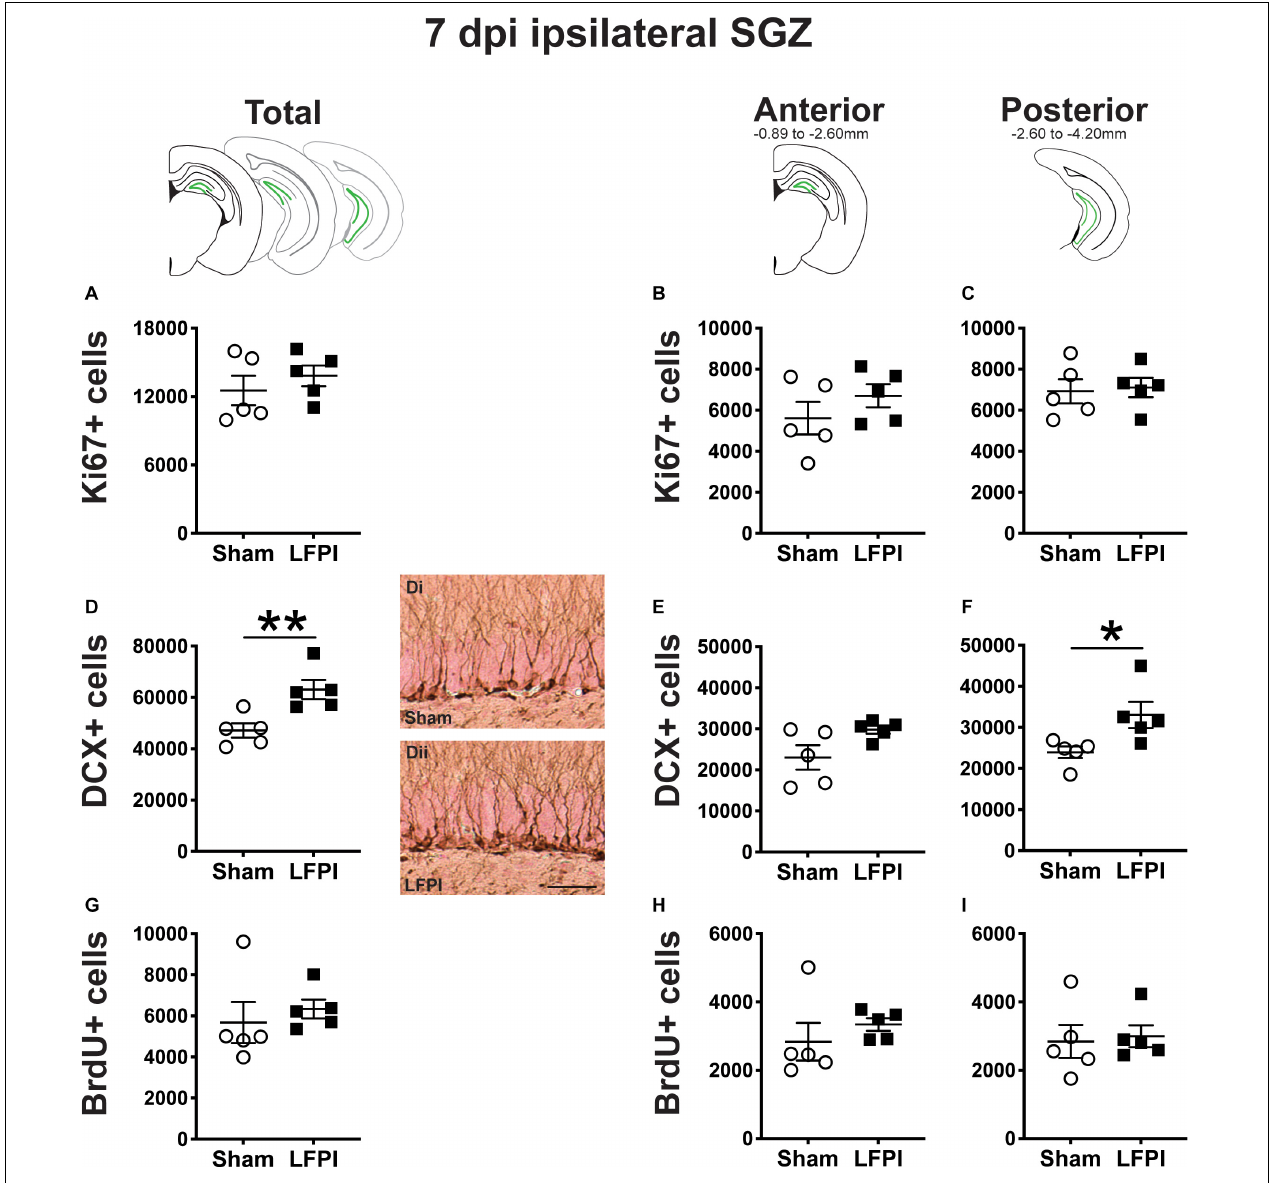
FIGURE 4 | Relative to Sham, LFPI increases the number of DCX+ neuroblasts/immatures neurons in the ipsilateral mouse SGZ/GCL 7 dpi. Green lines in schematics (top row) indicate these measures were taken in the ipsilateral SGZ/GCL. Stereological quantification of Ki67+ (A–C ; Sham n = 5, LFPI n = 5), DCX+ (D–F ; Sham n = 5, LFPI n = 5), and BrdU+ (G–I ; Sham n = 5, LFPI n = 5) cells in the SGZ (Ki67, BrdU) and GCL (DCX). Immunopositive cells were quantified across the entire longitudinal axis (A,D,G) , and also broken up into anterior (B,E,H) and posterior (C,F,I) bins, operationally defined as Bregma levels − 0.92 to − 2.6; and − 2.6 to − 3.97, respectively. Representative photomicrographs of Sham (Di) and LFPI (Dii) DCX-stained tissue are shown alongside quantification of total DCX+ cells. Scale bar = 50 µ m. T-test, * p < 0.05, ** p < 0.01.